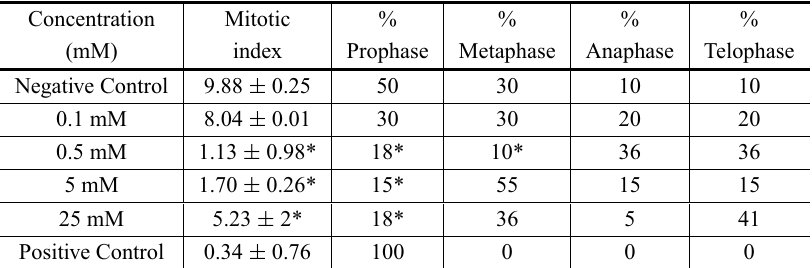
Negative Control: distilled water. Positive Control: MH 30 μ g/mL. Statistical analysis related to negative control * p < 0 . 05.